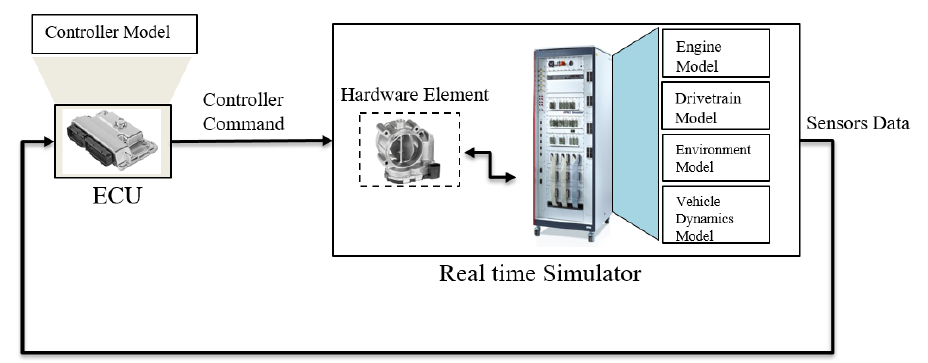
Figure 5. HiL real-time simulation with real